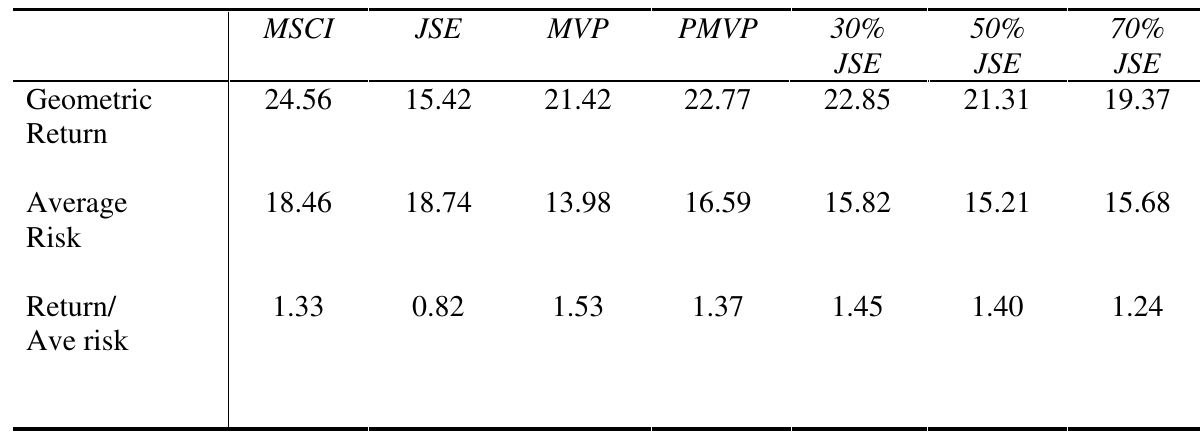
Table 5. Performance comparison 1983–1997